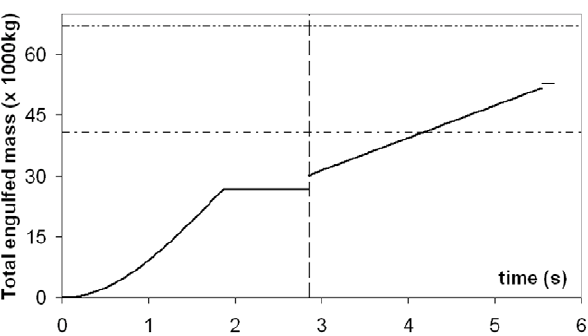
Figure 14. Simulated temporal variation of the engulfed mass for a 20.2 m fin whale. The cavity post-TMJ fills first during the first 66% of the mouth-opening (i.e., until 1.9 s here), to remain filled thereafter. This is followed by the filling of the cavity ant-TMJ during mouth closure. These are compared with the total mass capacity of the cavity post-TMJ (equation 9; dash-dotted line) and total capacity (sum of equations 9 and 10; dash-doubly-dotted). The body mass of this case is 40,705 kg.